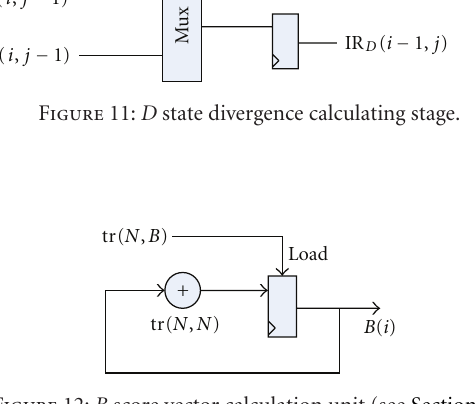
Figure 12: B score vector calculation unit (see Section 2).